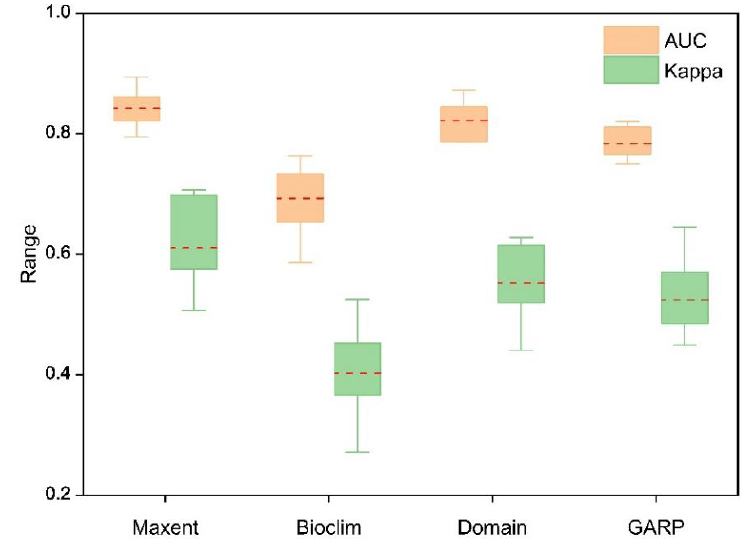
Figure 6. AUC and kappa values. (The red dotted line is the mean). Table 2. AUC and kappa values of the four models.